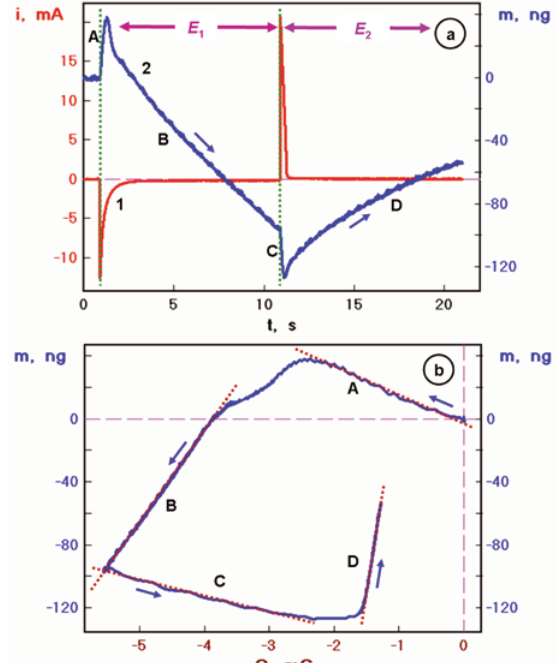
Figure 5. Mass transients for potential switching between E